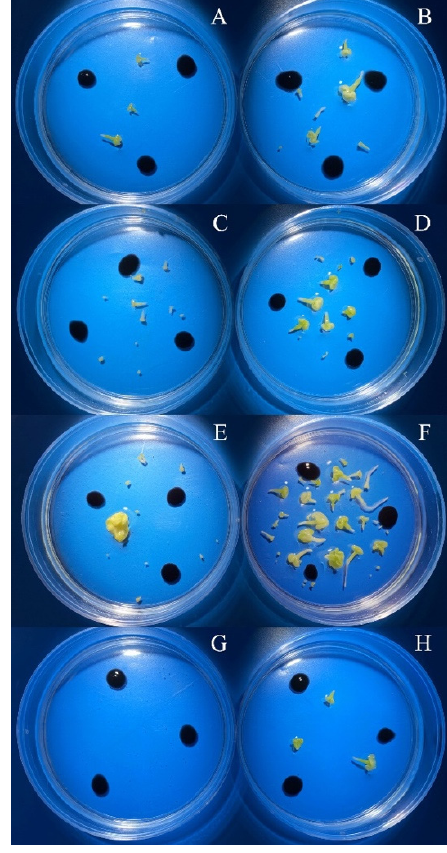
Figure 7. Yield of white cabbage ‘Parus’ embryoids at day 30 of culture depending on method of isolation and linear size of buds. ( A , C , E , G )—microspore isolation No. 2; ( B , D , F , H )—microspore isolation No. 3; ( A , B )—bud size 4.0–4.5 mm; ( C , D )—bud size 4.5–5.0 mm; ( E , F )—bud size 5.0–5.5 mm; ( G , H )—bud size 5.5–6.0 mm.